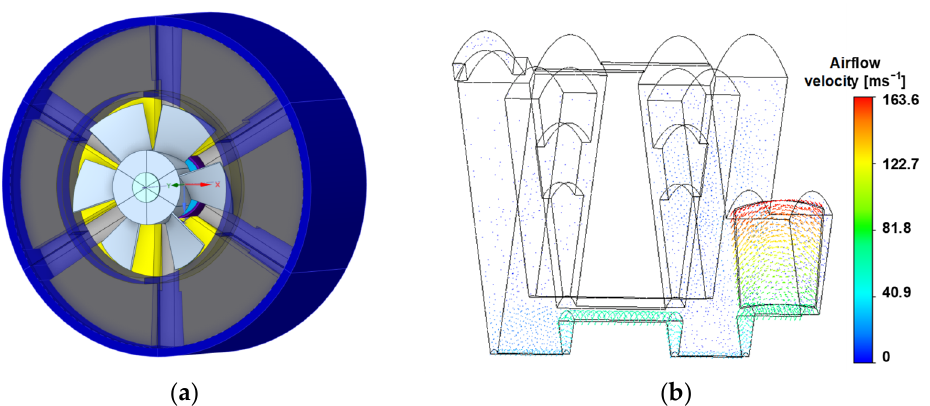
Figure 16. CFD result for a fan-cooling PM machine. ( a ) Machine prototype with coaxial fan. ( b ) Distribution of airflow velocity in air domain within